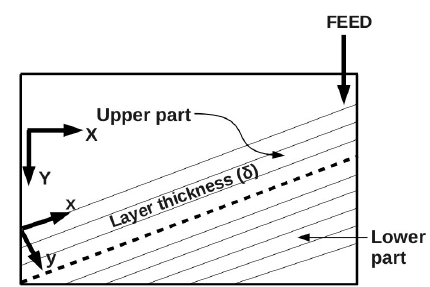
Figure 4. Layer thickness along showing upper part (top layer region) & bottom part (bottom layer